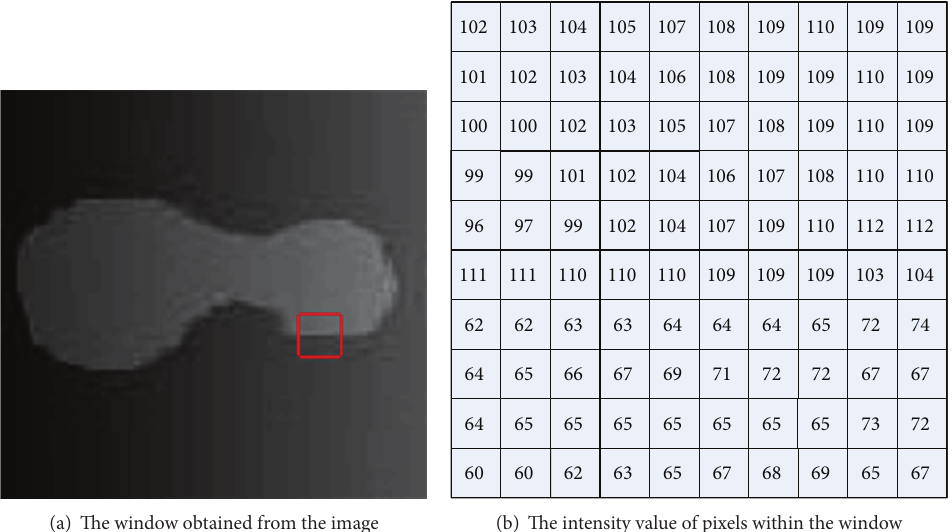
Figure 2: A 10 × 10 window obtained from a synthetic image marked with a red